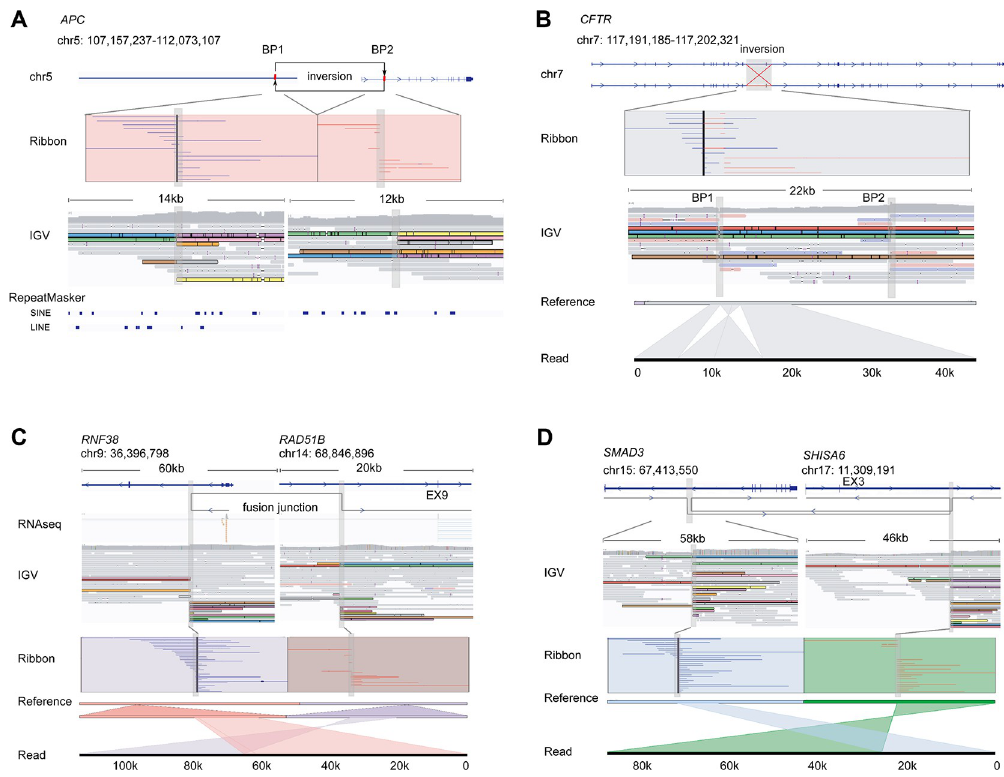
Fig 4. Large-scale inversions and gene fusions detected by nanopore sequencing. (A-D) Reads and structures of the 4,915 kbp inversion spanning exon 1 of APC (A), the 11.2 kbp inversion in CFTR (B), the RNF38-RAD51B gene fusion (C) and the SMAD3-SHISA6 gene fusion (D). For reads alignment, the reads spanning breakpoints were highlighted in colors. For each inversion, the top panel indicates the loci which inversion occurred, and read alignments coving the breakpoints (visualized by Ribbon). The forward and reverse split reads were marked by blue and red, respectively. The middle panel shows reads alignments around breakpoints (visualized by Integrative Genomics Viewer). The bottom panel shows the detailed structure of the SV (visualized by Ribbon). For each gene fusion, the top, middle and bottom panels show translocation loci, reads alignment and split reads, respectively.